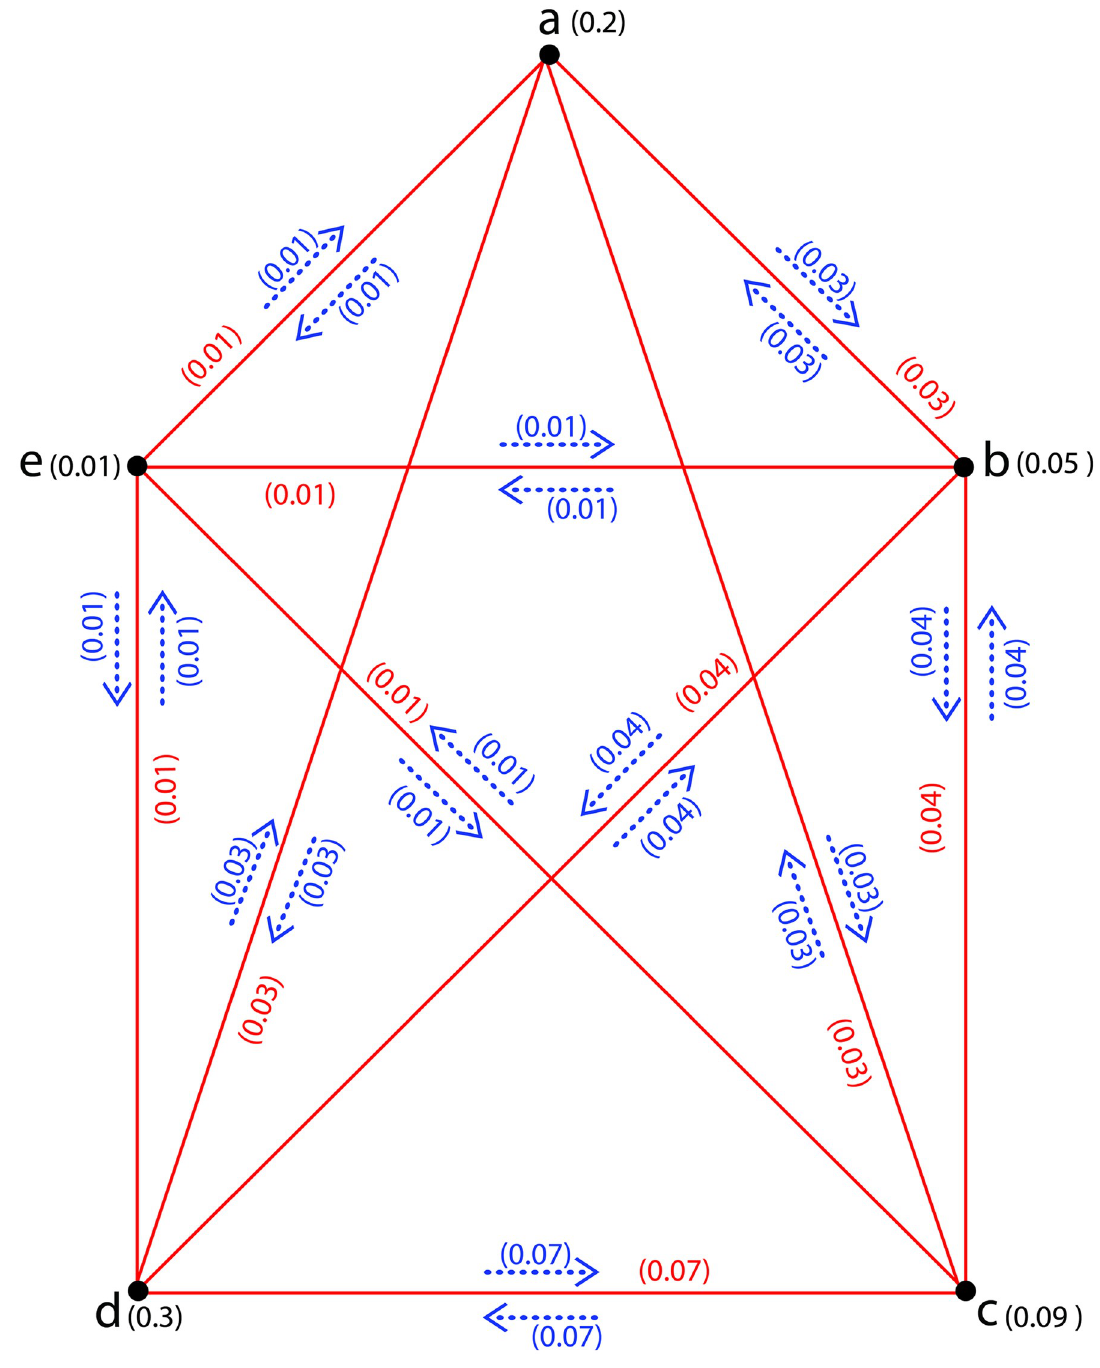
Fig 7. A CFIG with n